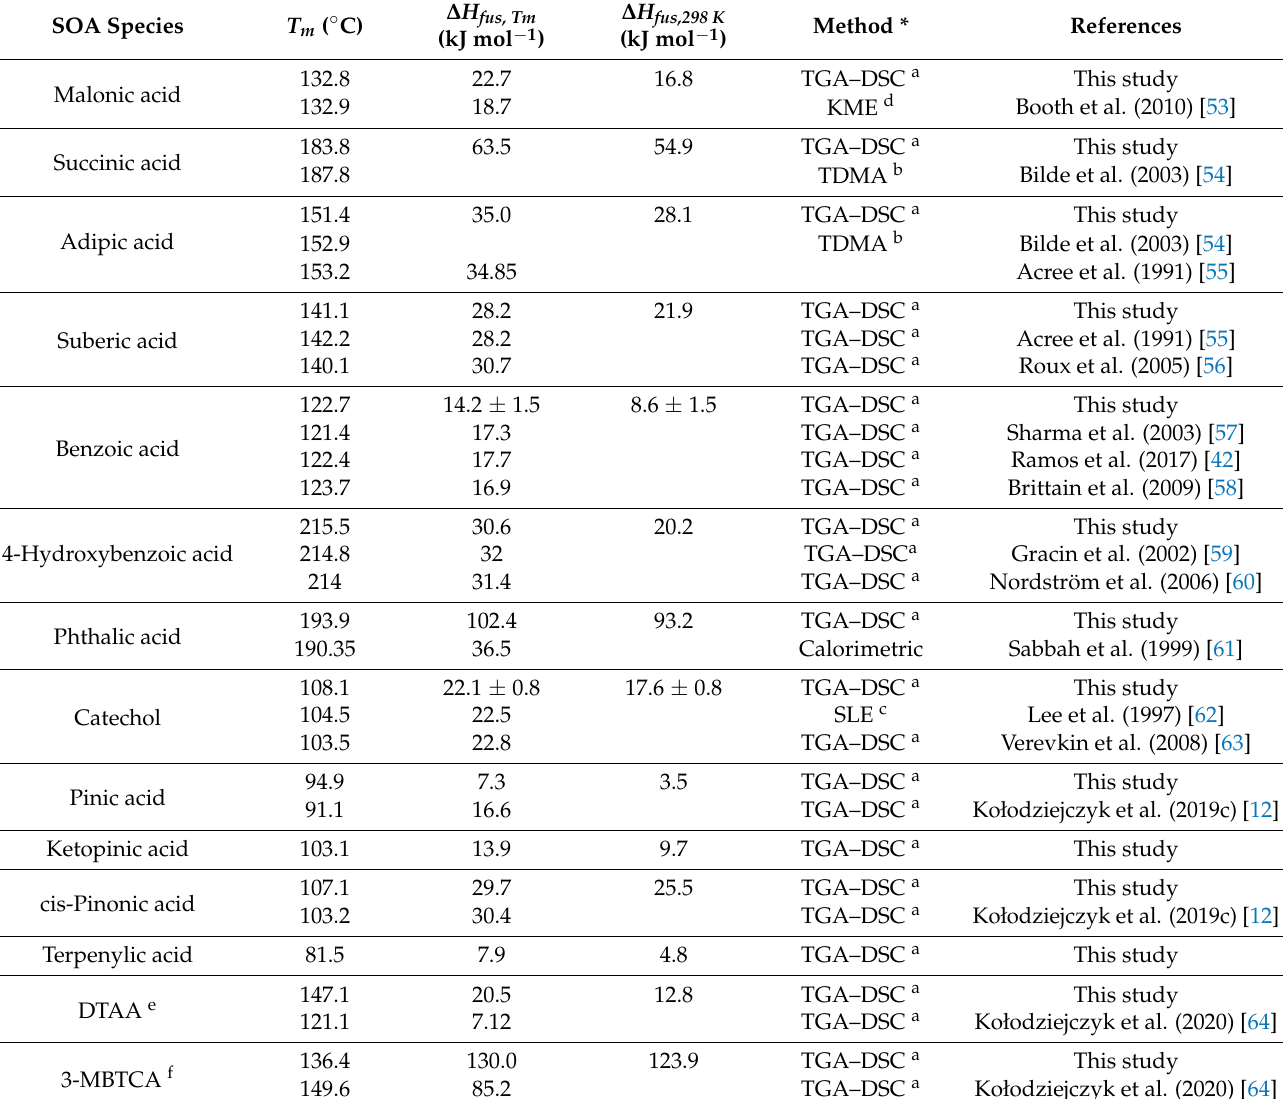
Table 2. Melting temperatures and melting enthalpies at melting and room temperature of biogenic and anthropogenic SOA